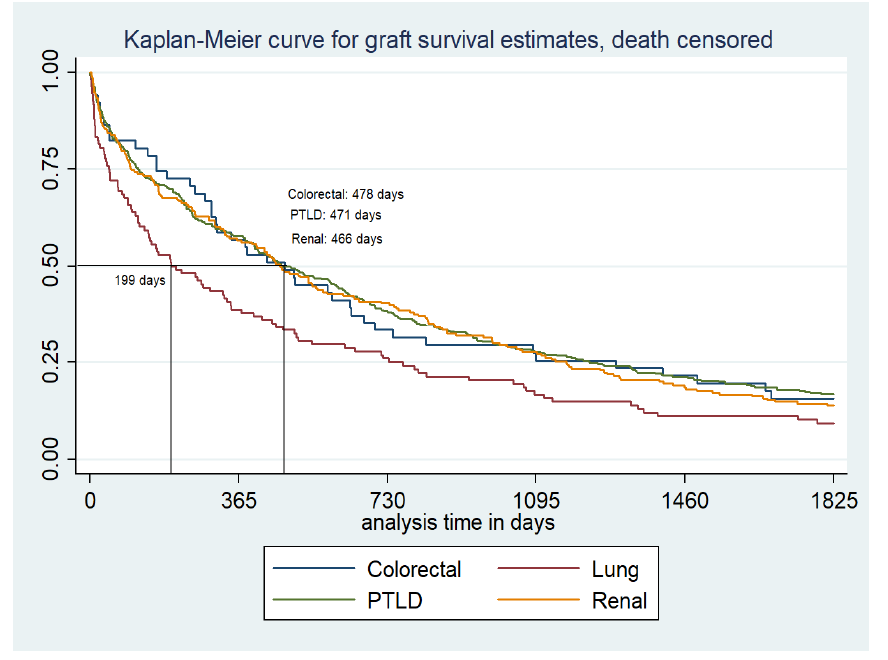
Figure 2. Death-censored graft survival from the diagnosis of malignancy (Kaplan–Meier).